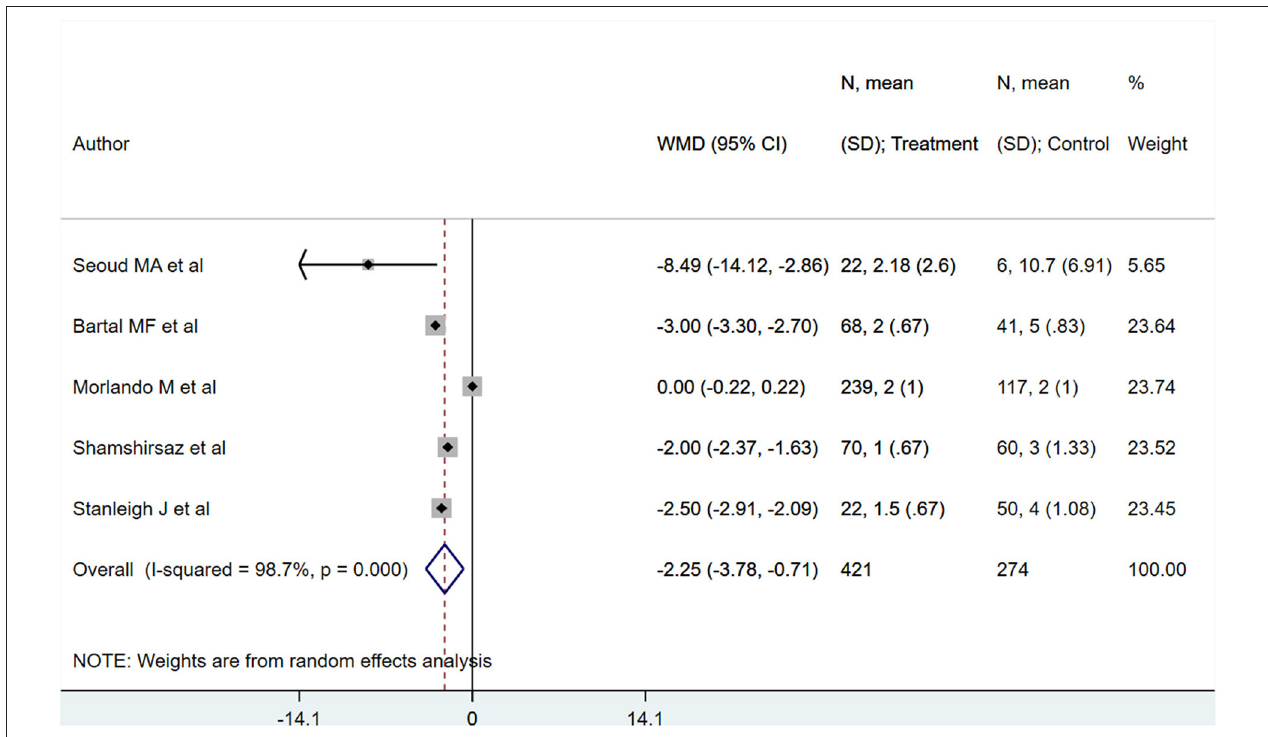
FIGURE 5 | Units of blood transfused for PAS patients undergoing planned or emergency delivery.